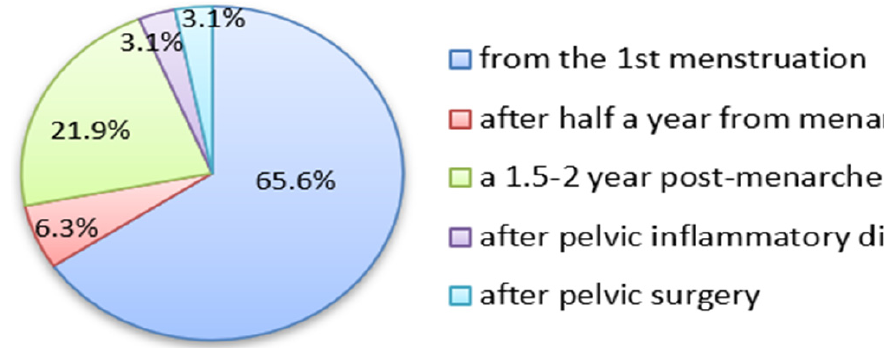
Figure 2. The structure of dysmenorrhea/pelvic pain onset since menarche. Most patients (53.1%, 17/32) considered their pain as of constant intensity (in retro- spect), whereas in 46.9% (15/32), the intensity increased over time since menarche (see Figure 3a).